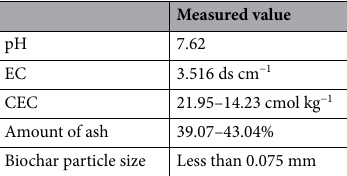
Table 1. Physical and chemical properties of biochar derived from water hyacinth.